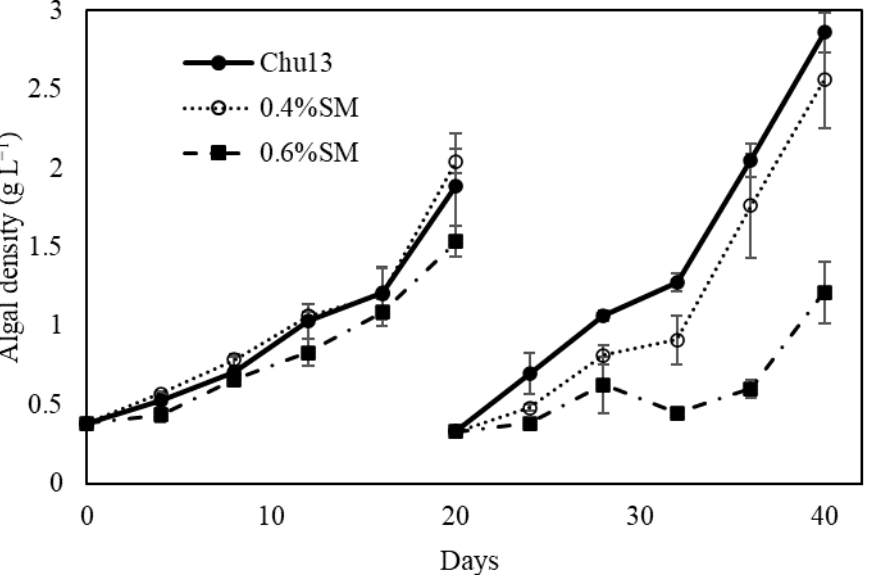
Figure 1. Growth rates of B. braunii Yamanaka strain cultured in different media. Black arrow indicates day 20 when algae were subcultured into new medium ( n = 3, mean ± SD).